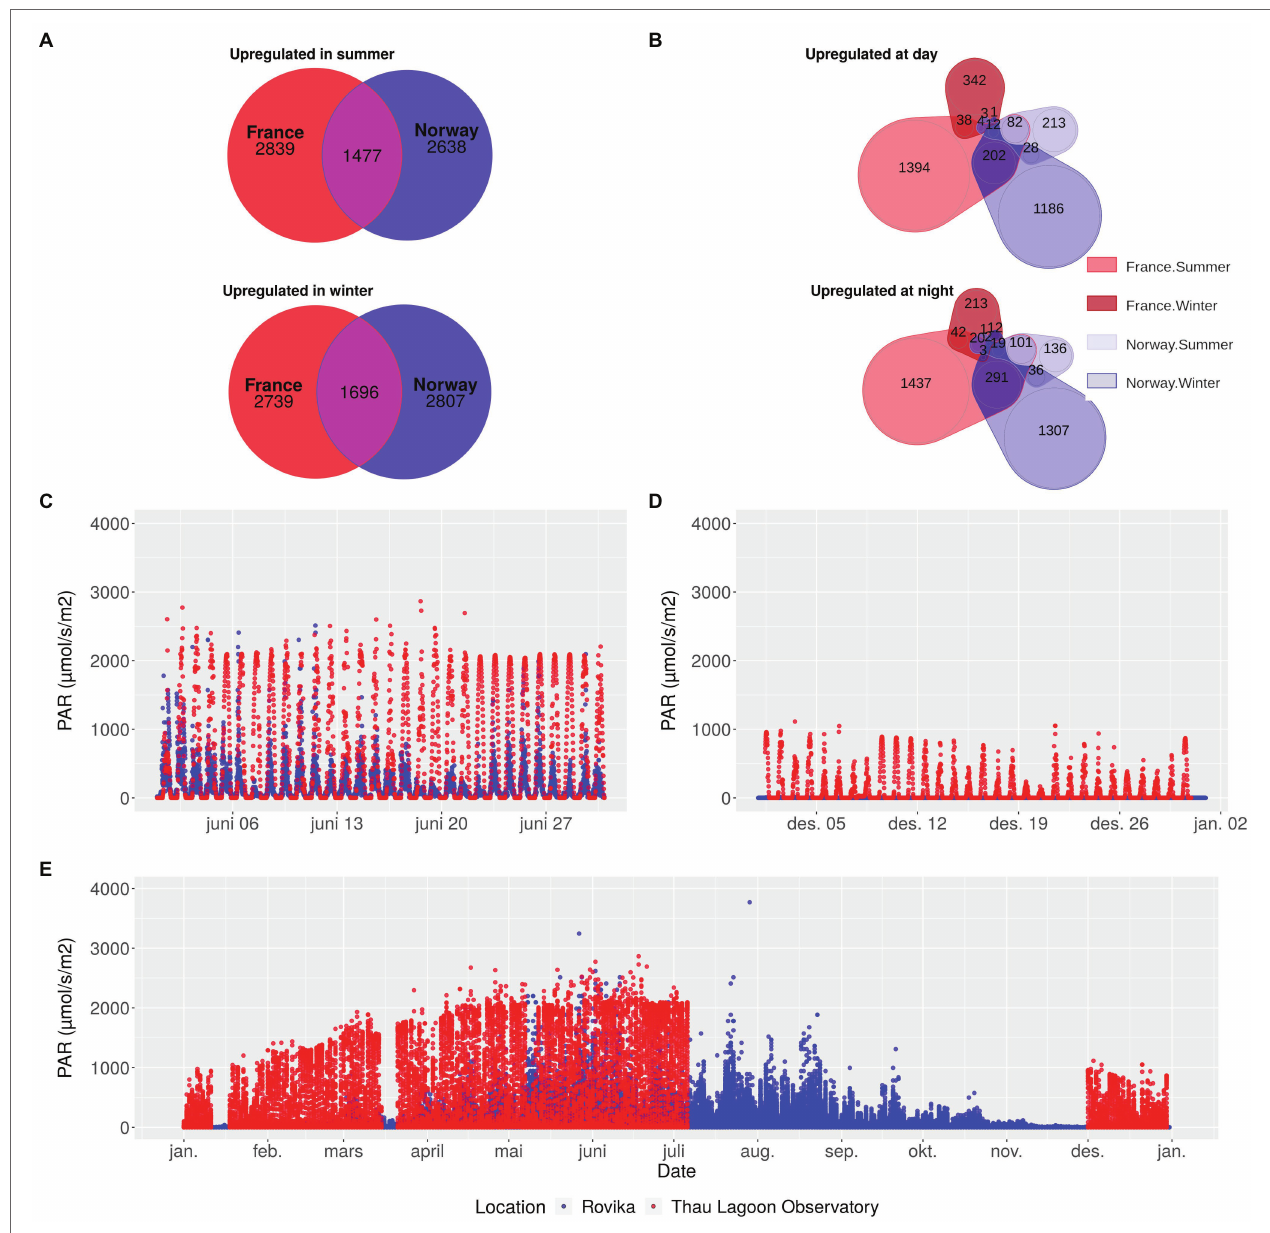
FIGURE 1 | Seasonal and diurnal gene expression changes of the Norwegian and French population of the seagrass Zostera marina in relation to differences in annual light conditions at the sampling sites. Number of genes upregulated in summer, and winter (A) in France and in Norway, or upregulated during day, and night (B) , separately for summer and winter. The subset of genes in A and B are independent from each other but partly overlapping. Light levels in June (C) , December (D) , and over the entire year (E) at the Norwegian sampling site (blue) and at an observatory station in the Thau Lagoon close to the French sampling site (red). In the Thau Lagoon, values are missing from July to December. PAR: Photosynthetically active